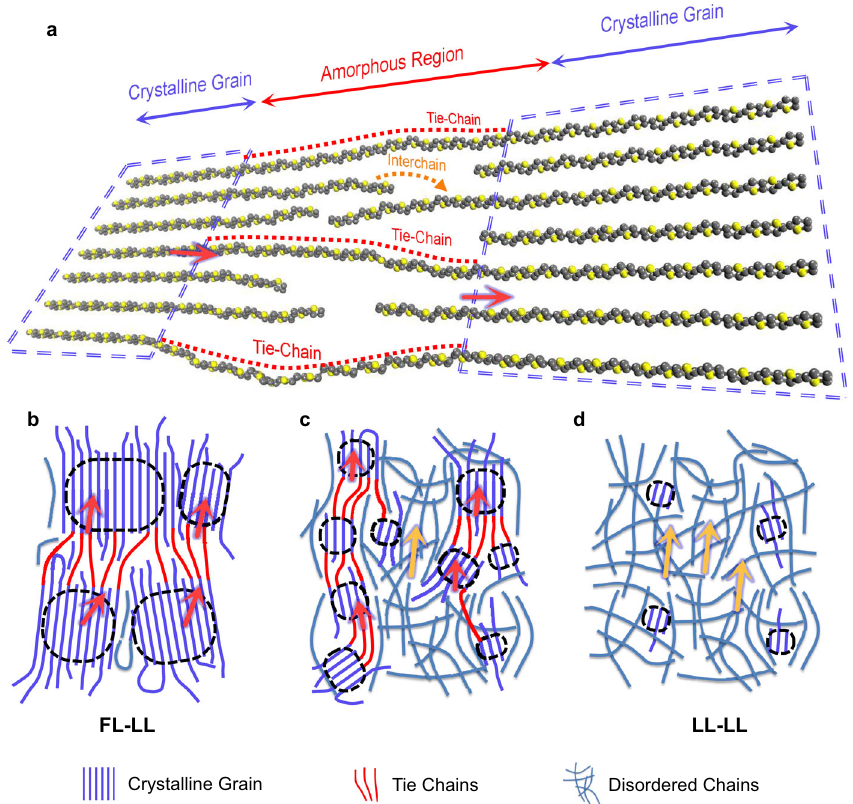
Fig. 3 Relationship between charge transport and microstructure in polymer fi lms. a Schematic illustration of the microstructure in the PBTTT fi lm with different degrees of crystallinity, including crystalline grains with well-ordered chains, tie-chains that connect two grains, and disordered chains in the amorphous region. Schematic diagram of grain and amorphous chain distributions in PBTTT fi lms with different degrees of crystallinity related to various possible transport paths: crystalline grain-tie-chain tunneling (denoted as red arrows) noted as FL – LL tunneling, related to the power-law in HC samples in b , coexisting of grain-tie-chain tunneling and chain-chain tunneling (denoted as orange arrows) in MC sample ( c ), and chain-chain tunneling in disordered PC samples, noted as LL – LL tunneling ( d ). The different dominated transport paths determine the fi nal nonlinear transport parameters displayed in Fig.